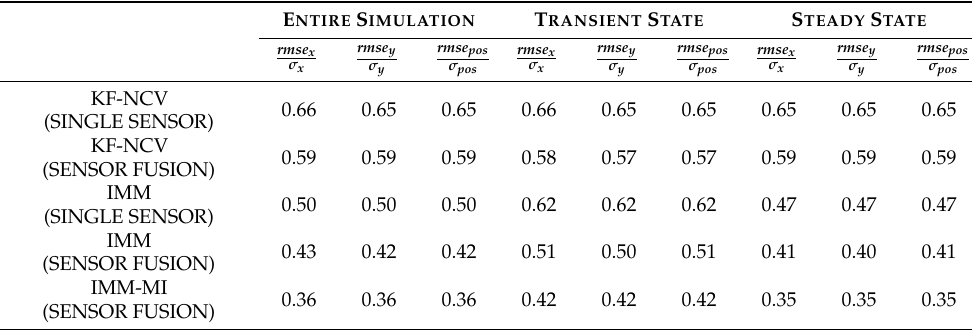
Table 4. Comparison of the performances of different tracking techniques on the simulated target under ideal